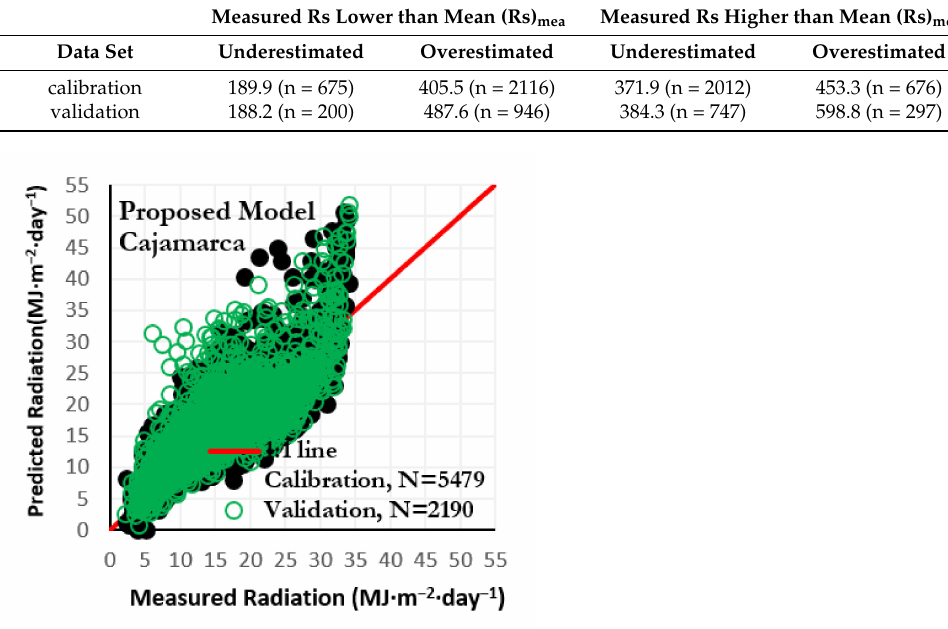
Figure 4. Solar radiation estimated by proposed model at Cajamarca station versus measured values in calibration and validation